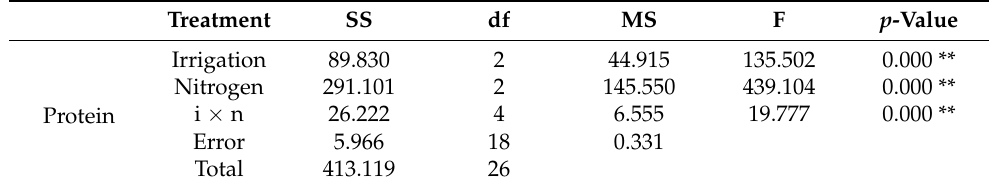
Table 3. Results of ANOVA on the effect of irrigation and nitrogen application on protein content of sunflower seed